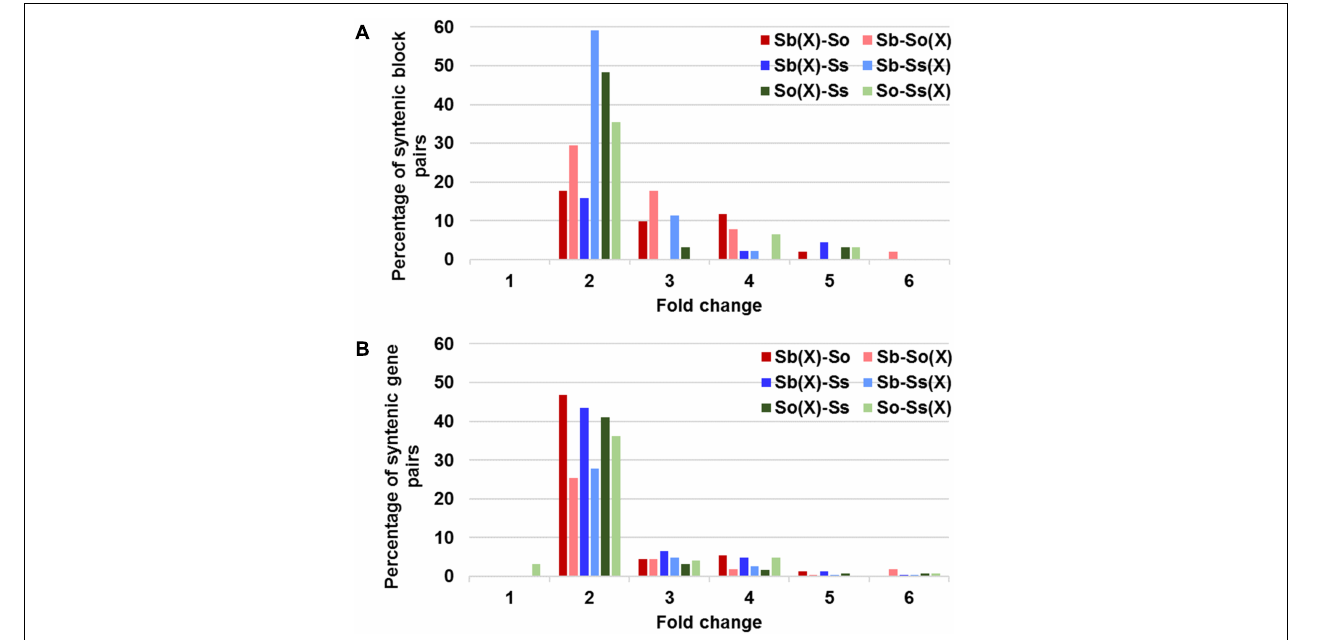
FIGURE 3 | Relative size expansion between Saccharum and sorghum and between Saccharum officinarum and Saccharum spontaneum in syntenic blocks (A) and syntenic gene pairs (B) . X: expansion.